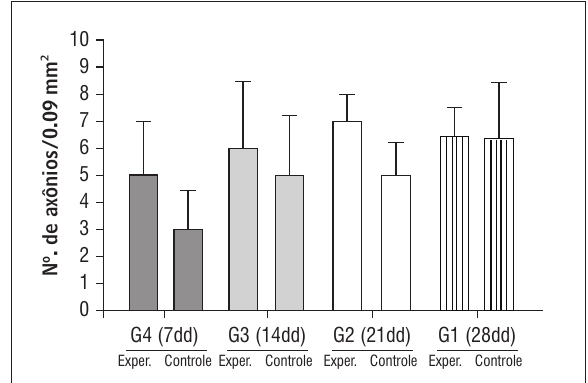
Figura 4 - Gráfico comparativo do número de axônios viáveis presentes no coto proximal dos grupos experimentais e controle